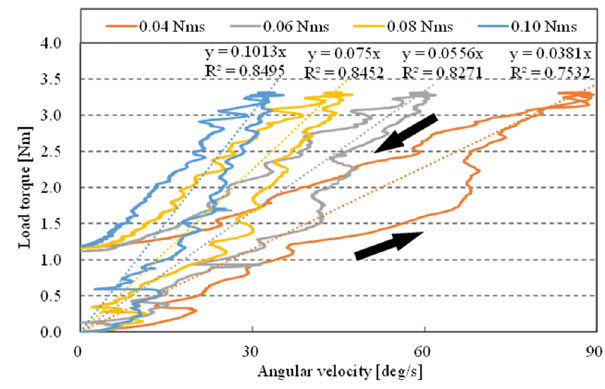
Figure 11. Measurement results of joint